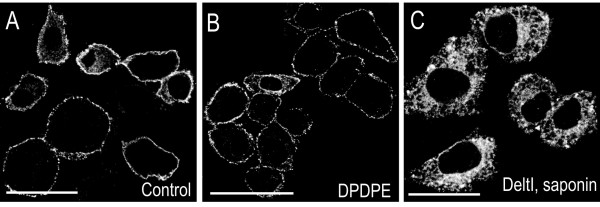
Characterization of the CHO-K1 cells stably expressing MYC-tagged human DOR. A. The cell surface receptors were visualized with an anti-MYC antibody and a fluorescent secondary antibody. B. The cells were treated with 100 nM DPDPE for 10 min at +37°C after which the remaining cell surface receptors were visualized with an anti-MYC antibody and a fluorescent secondary antibody. C. The cells were stimulated with 100 nM DeltI for 5 min at 37°C, permeabilized with saponin and the receptors were visualized with an anti-MYC antibody and a fluorescent secondary antibody. All the images are 0.5 μm confocal sections at the mid-nuclear level. Representative images are shown. Scale bar 20 μm.